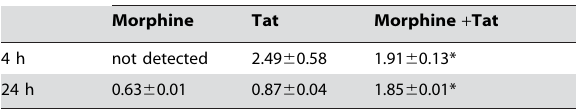
Table 1. Effects of morphine and/or Tat on c-Rel DNA binding activity in striatal astrocytes after 4 or 24 h continuous